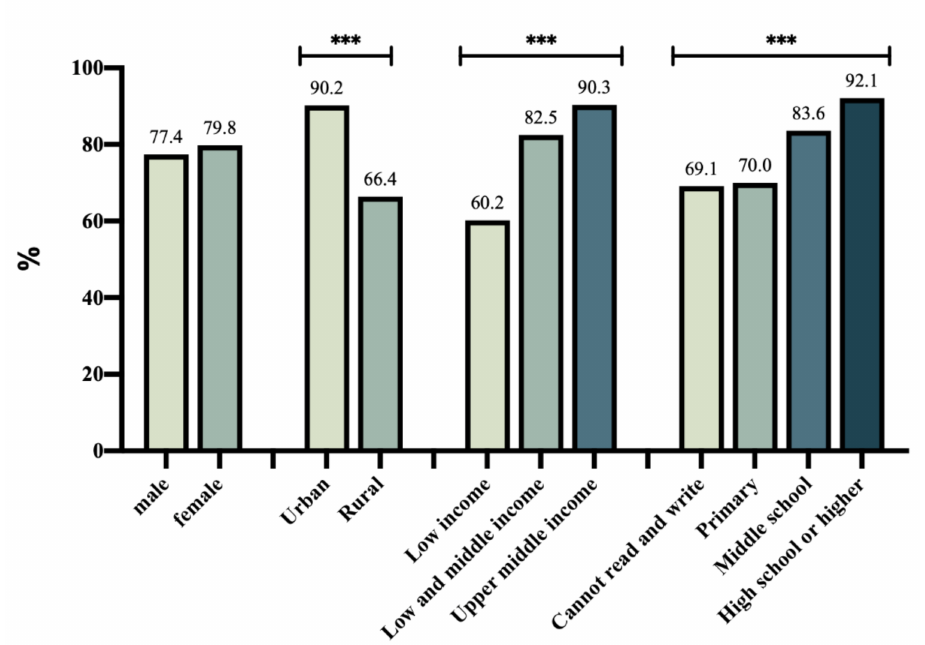
Figure 1. Percentage of participants who had washed hands regularly in the last 2 weeks. (***, p <